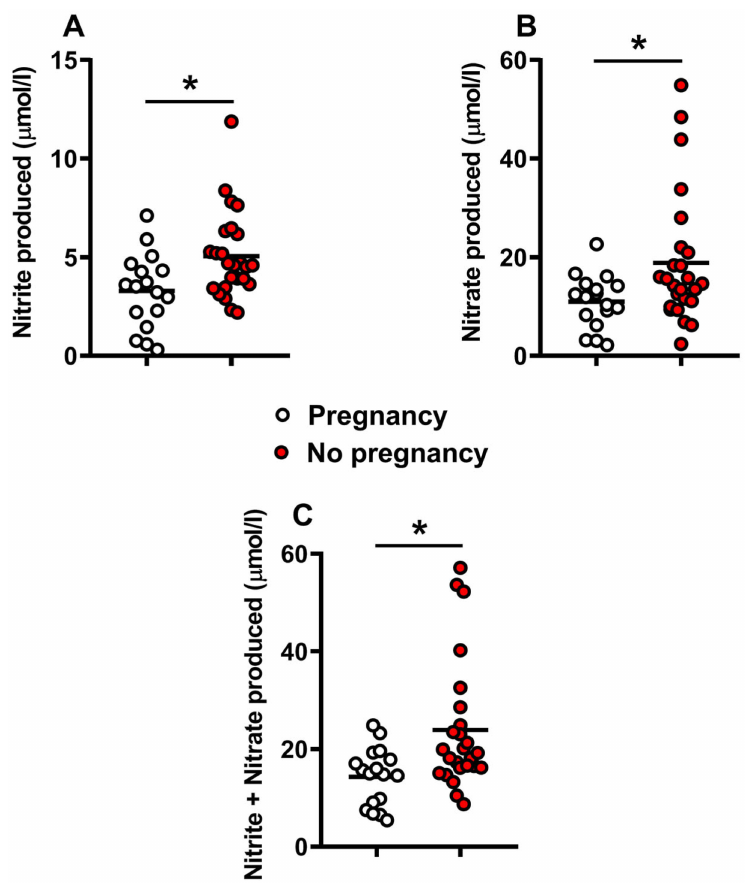
Figure 4. Concentrations of nitrite ( A ), nitrate ( B ), and nitrite + nitrate ( C ), as stable end-products of nitric oxide metabolism, detected in culture media of human embryos at 5 days post-fertilization. Embryos were divided into those with successful (n = 17, empty circles) or unsuccessful pregnancy (n = 25, red filled circles), independently on the embryo grade. The mean values are represented by the horizontal bars. * Significantly different from high grade, q < 0.01 ( A ), q < 0.05 ( B ), and q < 0.003 ( C